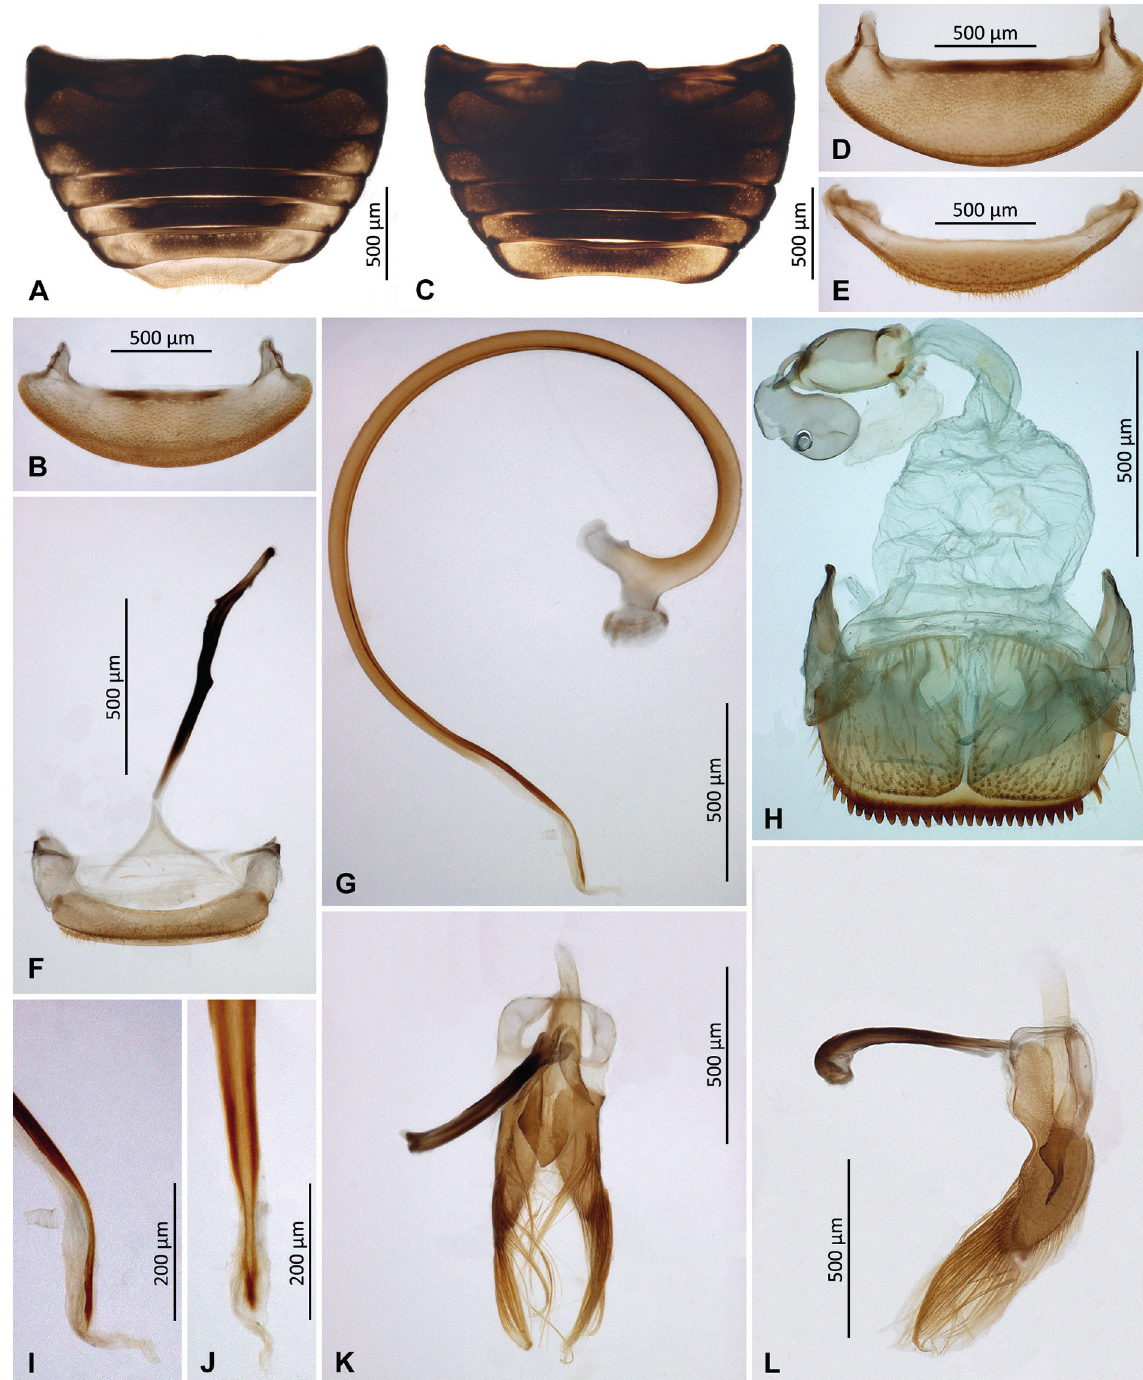
Fig. 13. Hyperaspis rutai sp. nov. A . Holotype (MNHW), ♂, abdomen. B . Holotype (MNHW), ♂, tergite VIII. C . Paratype (MNHW), ♀, abdomen. D . Paratype (MNHW), ♀, tergite VIII. E . Paratype (MNHW), ♀, ventrite 6. F . Holotype (MNHW), ♂, segments IX and X, dorsal view. G . Holotype (MNHW), penis, lateral view. H . Paratype (MNHW), female genitalia, ventral view. I . Holotype (MNHW), penis tip, lateral view. J . Holotype (MNHW), penis tip, inner view. K . Holotype (MNHW), tegmen, inner view. L . Holotype (MNHW), tegmen, lateral